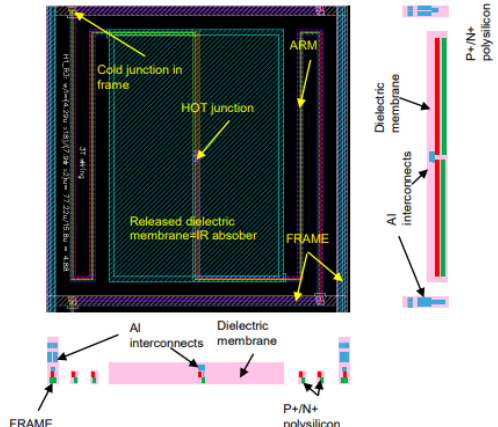
Figure 7. Layout and cross-sectional views of the proposed thermopile pixel.